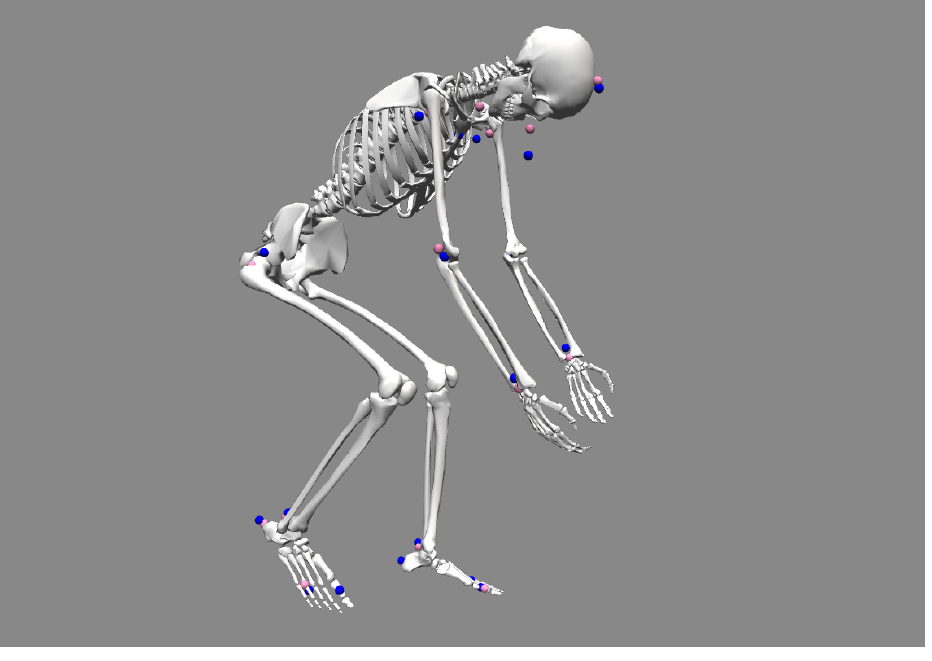
Figure 7. OpenSim inverse kinematics on cycling (C). Model markers are pink; experimental markers are blue.